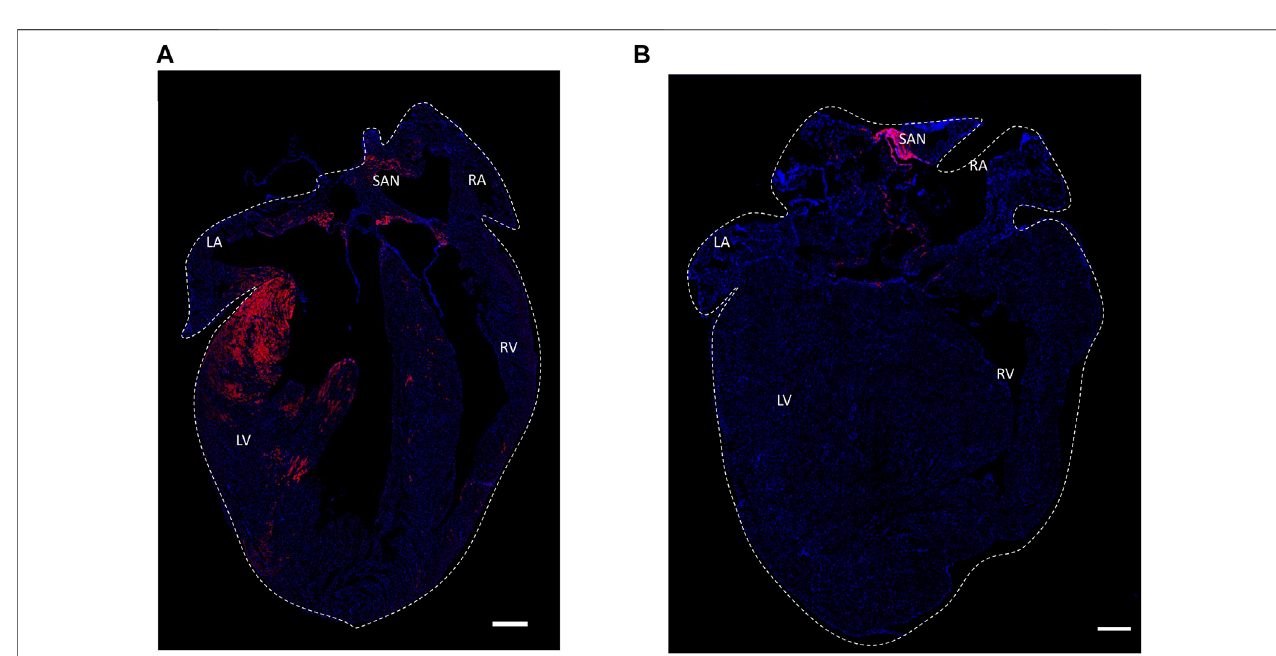
FIGURE 7 | Histological section confocal microscopic images of expression of distribution patterns of the HCN4 + cells in Hcn4 DreER/tdTomato heart (A) and Pnmt + / TdtomatopositivecellsinPnmt Cre/ChR2 − tdTomato heart (B) .Tdtomato fl uorescencesignalindicatingPdCMswasobservedontheleftsideoftheheartandSANregion. (B) Tdtomato fl uorescence signal was mainly observed in the SAN and AVN regions in Hcn4 DreER/tdTomato heart. Blue: nuclear staining by DAPI. Scale bar: 500 μ m. Online video1:ThevideowasgeneratedtoshowtheHCN4+cells(tdTomato)inanadultmouseheart.Thevideocanbefoundinthefollowinglink:https:// fi gshare.com/s/ 26bbc6c38ae7a01c7778heartsize:10.05 mm×12.01mmx7.565 mm. Onlinevideo 2:ThevideowasgeneratedtoshowthedepthdetailsofHCN4+cellsintheadult mouse heart. The video can be found in the following link: https:// fi gshare.com/s/21c472847c46f0936dddheart size: 10.05 mm × 12.01 mm x 7.565 mm. Online video 3: The video was processed to show the PdCMs (tdTomato) in the adult mouse heart. The video can be found in the following link: https:// fi gshare.com/s/ 01471ea1c3eda4f6bc43.heartsize:7.86mm×11.26mmx6.113 mm.Onlinevideo4:ThevideowasprocessedtoshowthedepthdetailsofPdCMsintheadultmouse heart. The video can be found in the following link: https:// fi gshare.com/s/4d9bb0b180cb58c3082f heart size: 7.86 mm × 11.26 mm x 6.113 mm.